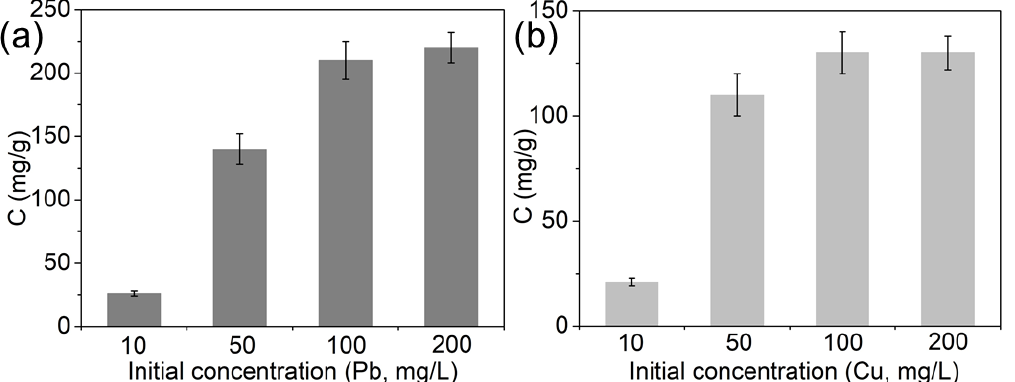
Figure 8. Adsorption capacity of magnetic MIL-68(Ga) on Pb 2+ ( a ) and Cu 2+ ( b ). (50 mg/L of metal ions, 200 mg/mL of adsorbent, 1 mL solution, pH = 7, room temperature, 30 min of incubation time).